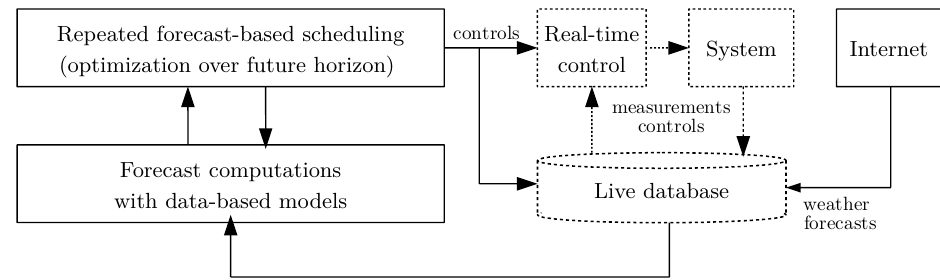
Figure 1. Concept of the forecast-based reactive scheduling as applied in the real-world setup. Solid lines indicate data flow belonging to schedule computations and dotted lines data flow which is only visible to and used by real-time control, actuators, and